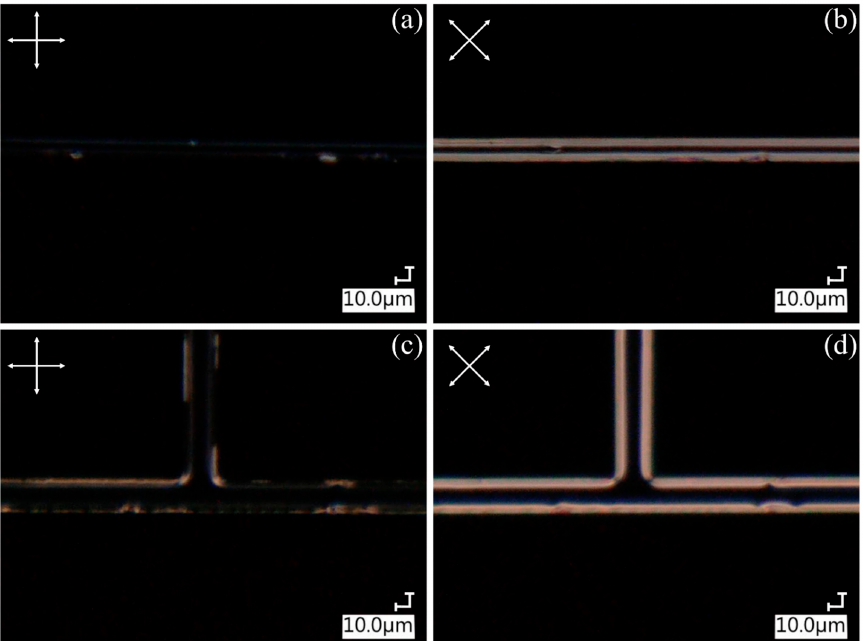
Figure 5 . PDMS:glass structures with a single microchannel filled with E7 NLC and observed under the polarizing microscope. Channels with the widths of approximately 11 µ m (designed to be 15 µ m) ( a , b ), and of approximately 17 µ m (assumed to be 21 µ m) ( c , d ). The orientation of polarizers’ axes is indicated in each photo.